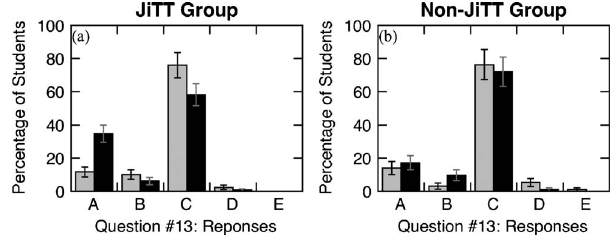
FIG. 5. Student responses to FCI question no. 13 on the pretest (cid:1) gray (cid:2) and post-test (cid:1) black (cid:2) . The correct response is A and the pri-